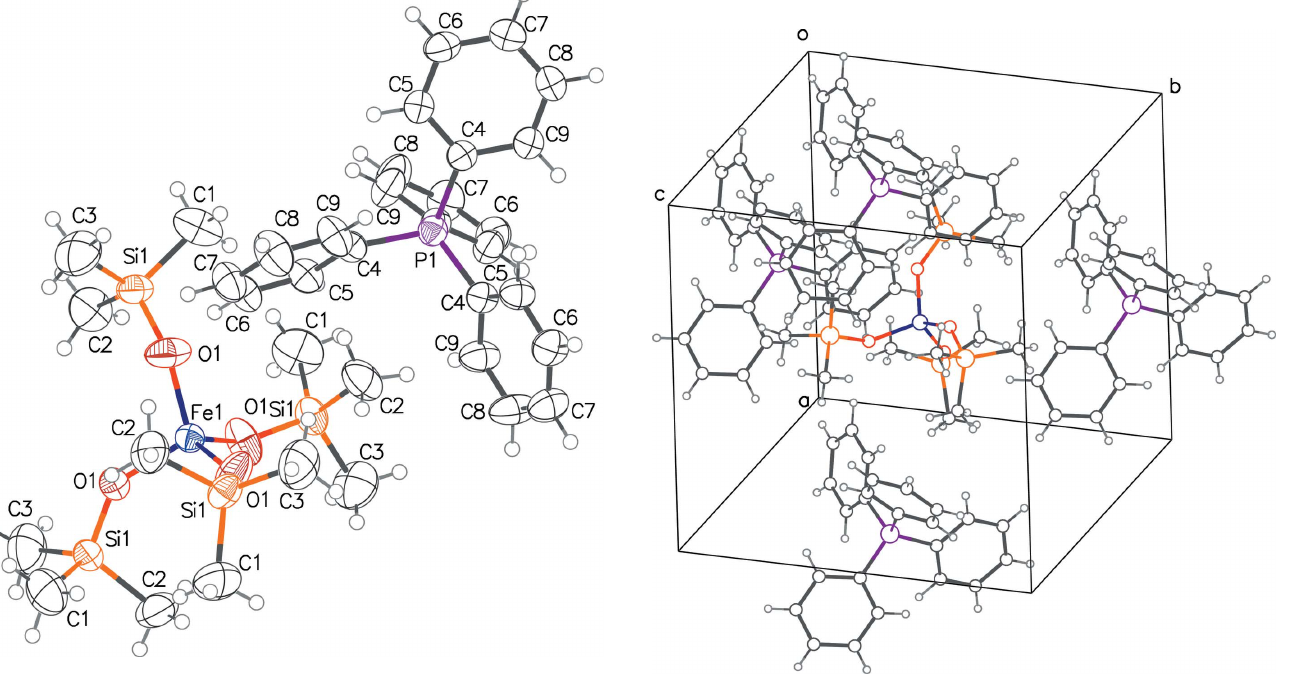
Figure 2 A packing diagram showing the ferrate anion surrounded by four phosphonium cations.